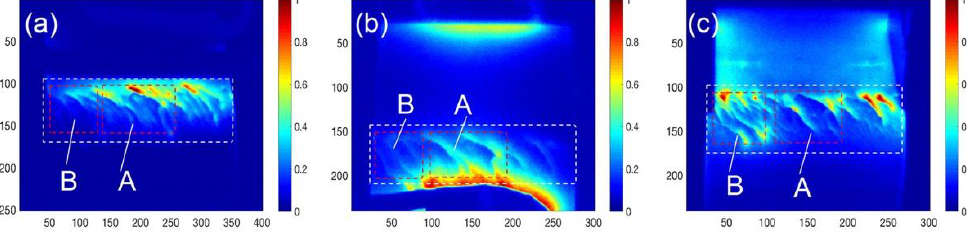
Figure 10. Experimental results of ECPT for the same sample with RCF multiple cracks using ( a ) line-coil. ( b ) Helmholtz-coil and ( c ) ferrite-yoke excitation configurations. Table 1. Defect detection performance comparison of different ECPT excitations with SNR in dB.